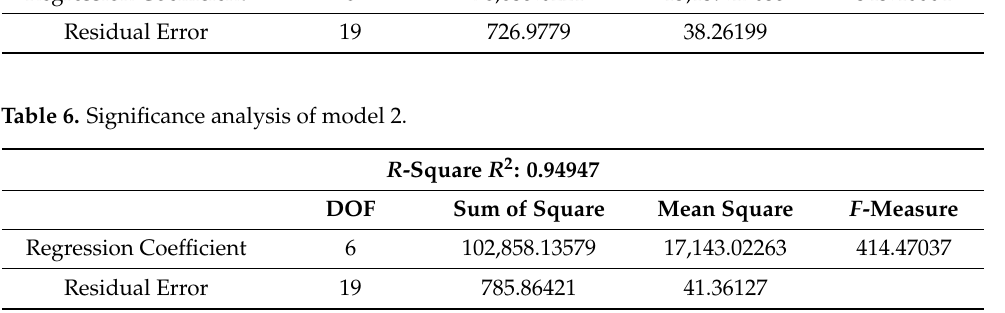
Table 5. Significance analysis of model 1.